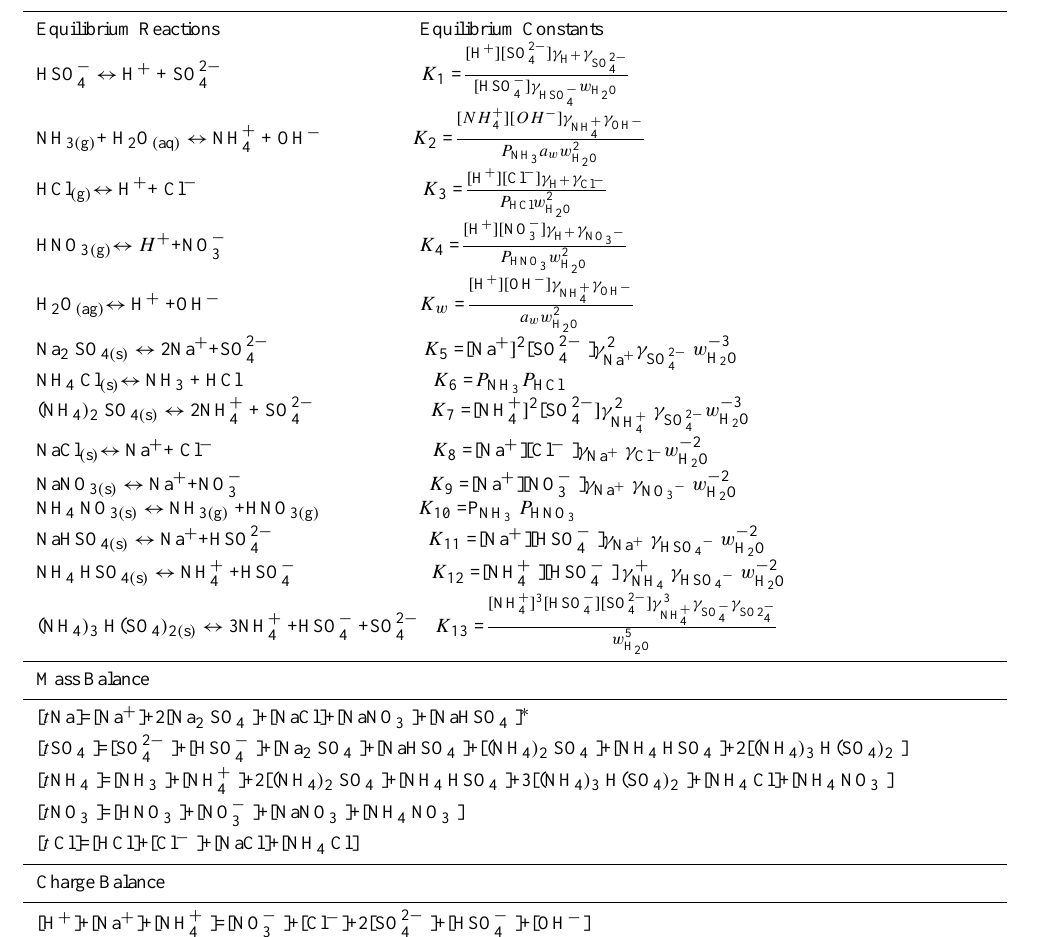
Table 1. Equilibrium Relations, mass and charge balance of